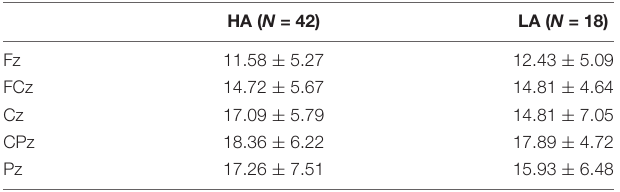
TABLE 3 | P200 amplitude of each group in 2-back task ( µ V, mean ± standard deviation).